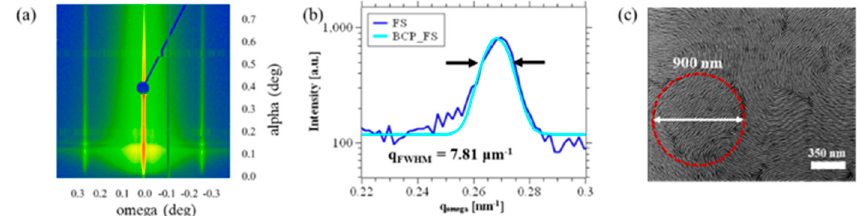
Figure 6. Estimating the limits of the directed self-assembly by grain-boundary-induced alignment. ( a ) Grazing-incidence small-angle X-ray scattering (GISAXS) pattern of randomly assembled block copolymer features; ( b ) estimation of the full-width at half maximum (FWHM) of the block copolymer grating truncation rod (GTR) to estimate the mean correlation length ξ of the sample; ( c ) SEM image of finger-print pattern with a circle representing the mean grain size as determined by the analysis of the GISAXS pattern.